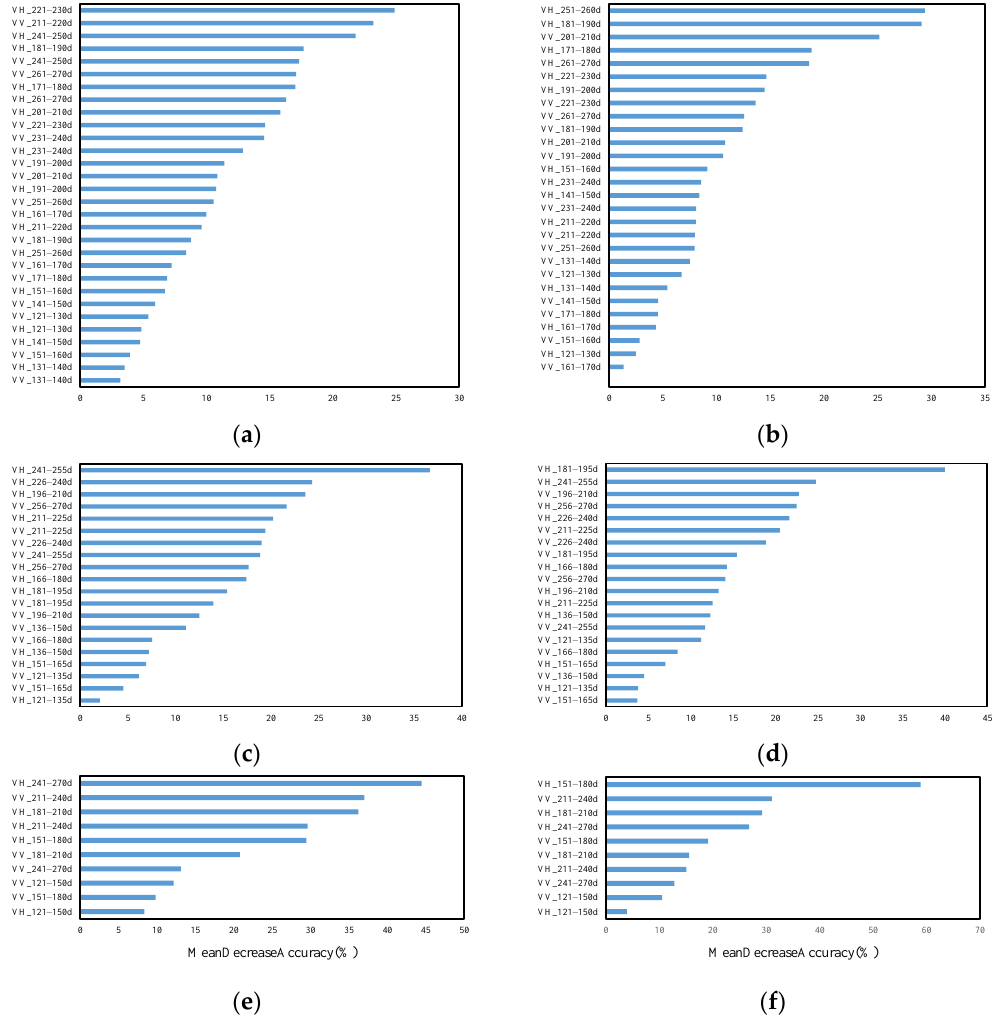
Figure 10. Importance assessment of crop classification features in 2018 and 2019 of Keshan farm with different time interval composite images (( a ) MeanDecreaseAccuracy_2018_10d; ( b ) MeanDecreaseAccuracy_2019_10d; ( c ) MeanDecreaseAccuracy_2018_15d; ( d ) MeanDecreaseAccuracy_2019_15d; ( e ) MeanDecreaseAccuracy_2018_30d; ( f ) MeanDecreaseAccuracy_2019_30d).